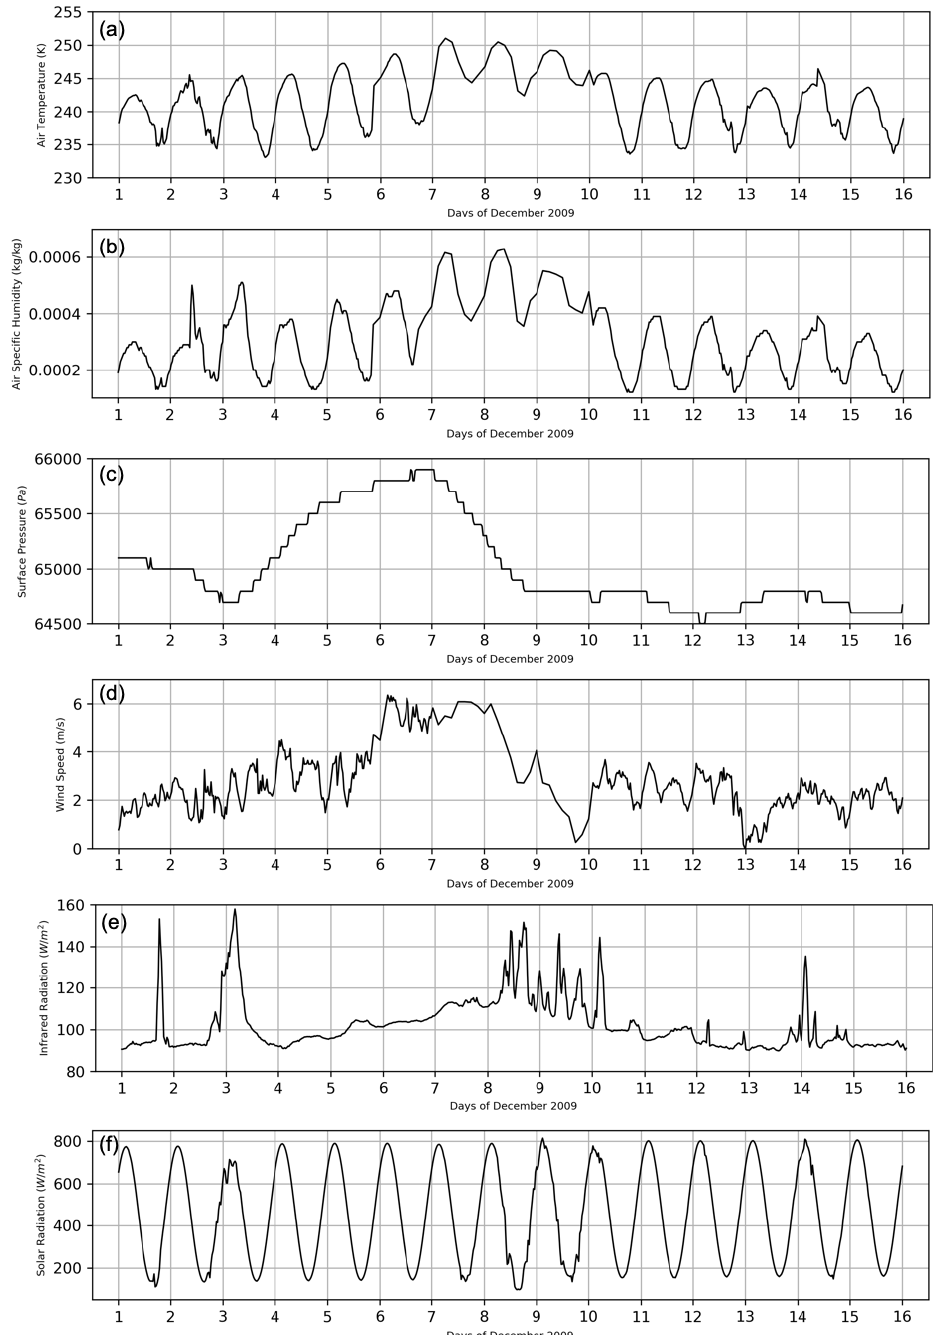
Figure 1. Temporal evolution of (a) air temperature, (b) air specific humidity, (c) surface pressure, (d) wind speed, (e) downward infrared radiation, and (f) downward solar radiation for the 15d period of the offline